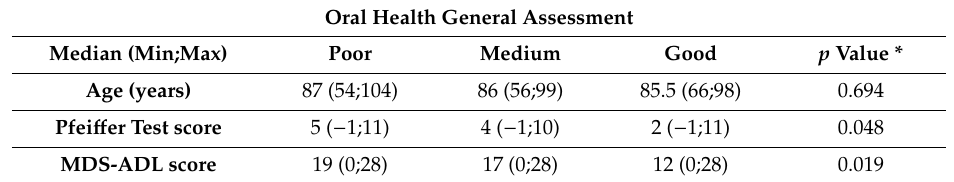
Table 3. The age, score at the Pfei ff er test and score at MDS-ADL for the oral health general assessment in a study of oral health in nursing homes in Florence, Italy, October 2017–October 2018 ( n =